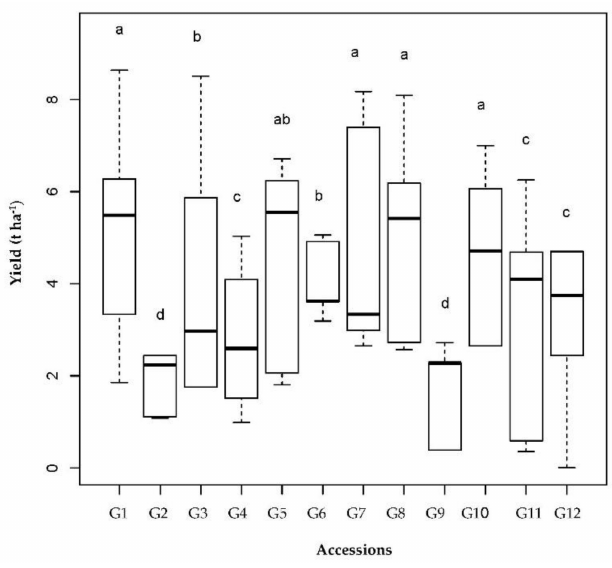
Figure 4. Boxplots of SY (t ha − 1 ) of the 12 chickpea accessions. Accessions followed by a different let- ter in each row are significantly different according to the Tukey HSD (honestly significant difference) test ( p = 0.05). The values from 1 to 12 represent the different accessions (see Table 1 for more details). Box edges represent the upper and lower quantile with the median value shown in the middle of the